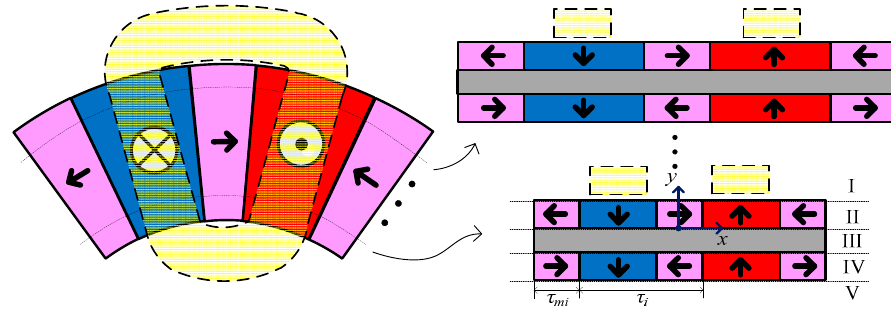
Figure 4. Quasi-3-D multi-slice model.